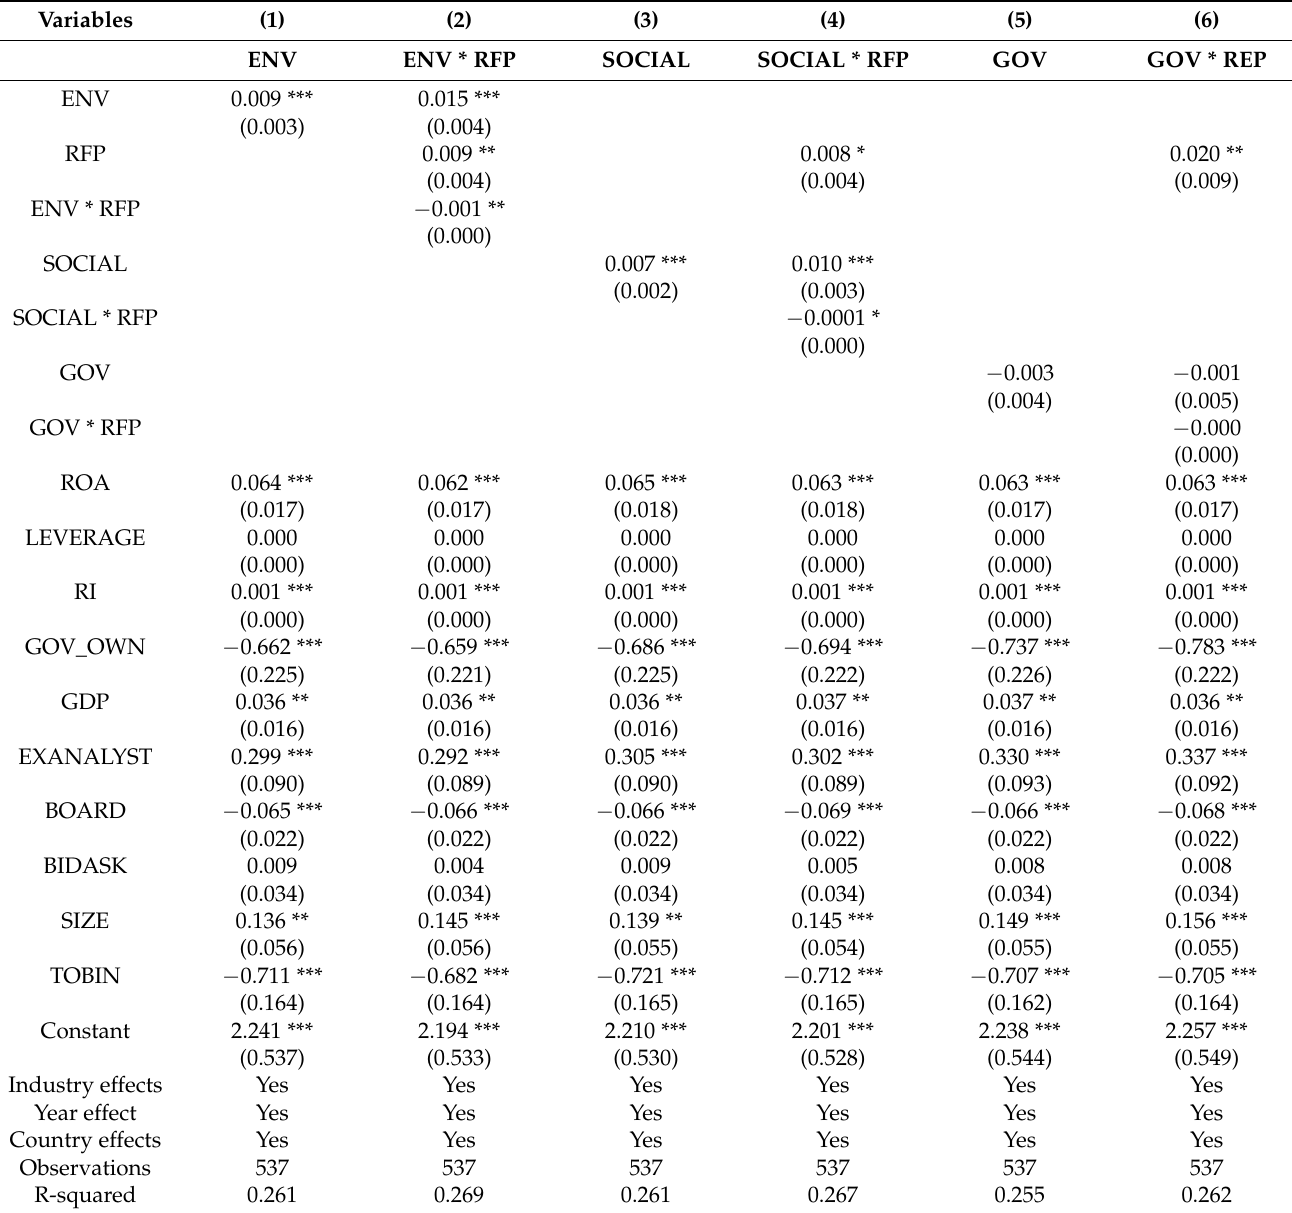
Table 9. Sub-analyses with individual ESG index; ENV, SOCIAL, and